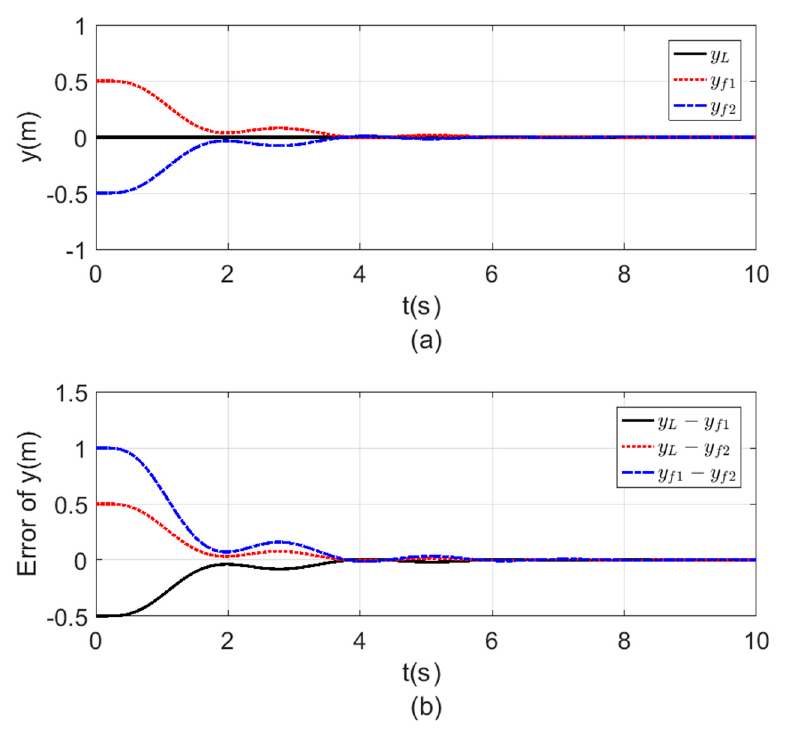
Figure 9. Consensus in y -position ( a ) y -position time response. ( b ) Error of the y Figure 9. Consensus in (cid:1877) -position ( a ) (cid:1877) -position time response. ( b ) Error of the (cid:1877) -position. Figure 9. Consensus in (cid:1877) -position ( a ) (cid:1877) -position time response. ( b ) Error of the (cid:1877) -position.